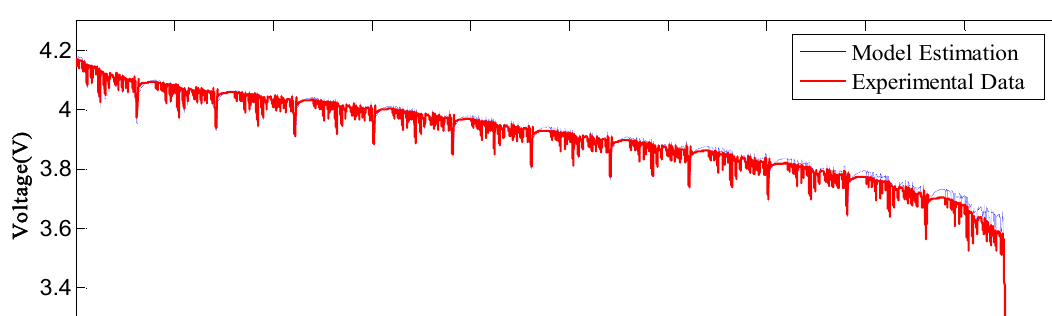
Figure 6. Comparisons between voltage of the model and the